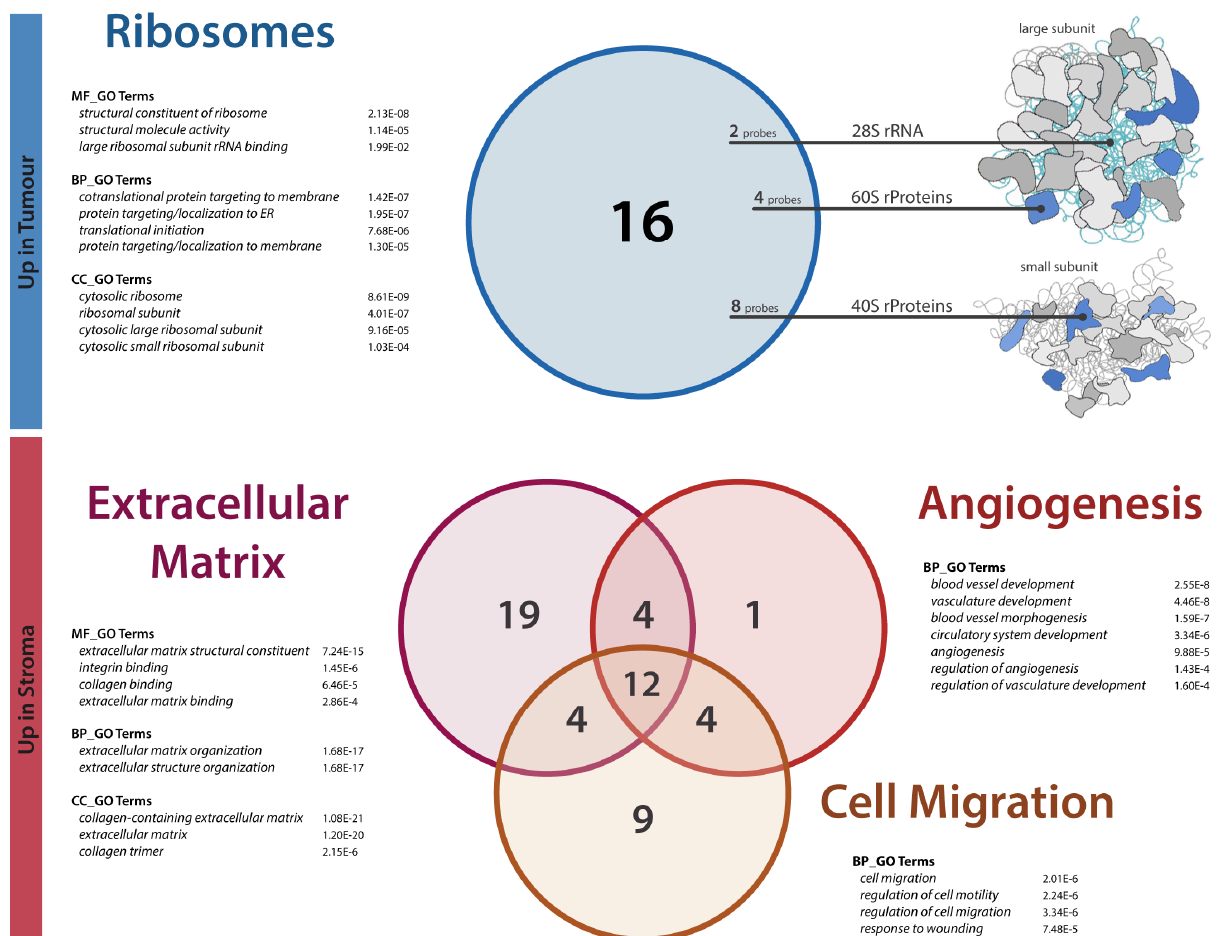
Figure 2. Macro clusters from the functional enrichment analysis of the DEG lists. Upper (blue) section: Cytosolic ribosome structural constituents, translation, and protein targeting to the membrane and ER were the main GO terms that were significantly enriched from the functional analysis of the genes overexpressed in tumours compared to stromata. Except for the two pseudogene probes, all elements of this set are also represented as coloured elements in the ribosome model on the right (modified from KEGG Pathway: Ribosome, 03010 11/12/20, Kanehisa Laboratories). Lower (red) section: Overall, extracellular matrix, angiogenesis, and cell migration GO clusters encompass most of the genes significantly less expressed in tumour than in stromal samples, or equivalently enhanced in the stromal compared to the tumour compartment. In both sections, Venn diagrams show the number of significant probes within each cluster. Below cluster names, the most representative GO terms are reported, together with their q-values as returned from the ToppFun hypergeometric test (MF = molecular function; BP = biological process; CC = cellular